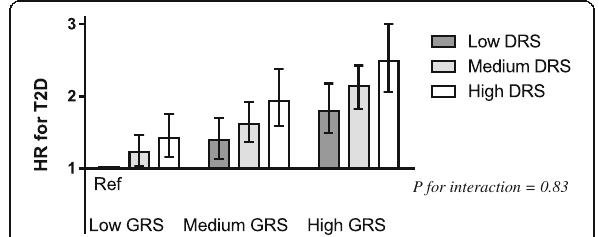
Figure 1 Hazard ratios of incident type 2 diabetes according to combinations of a genetic risk score and a dietary risk score for type 2 diabetes among individuals in the Malmö Diet and Cancer Study ( n = 25,069). No statistical interaction was observed between the genetic and dietary risk scores ( P = 0.83). Individuals with both high genetic susceptibility and unfavourable dietary habits had more than twice as high risk (HR 2.49; 95% CI 2.06, 3.01) of developing T2D compared to those with low genetic susceptibility and favourable dietary habits (reference HR =